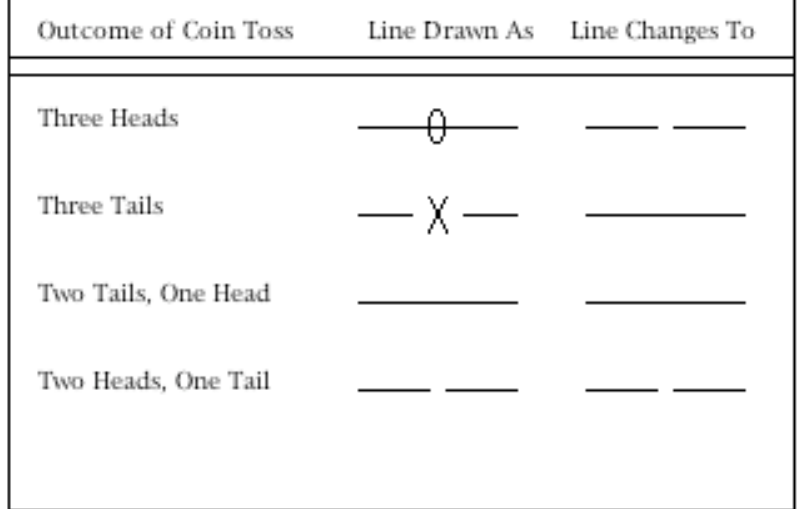
Figure 4.2. Mapping coin toss to possible hexagram